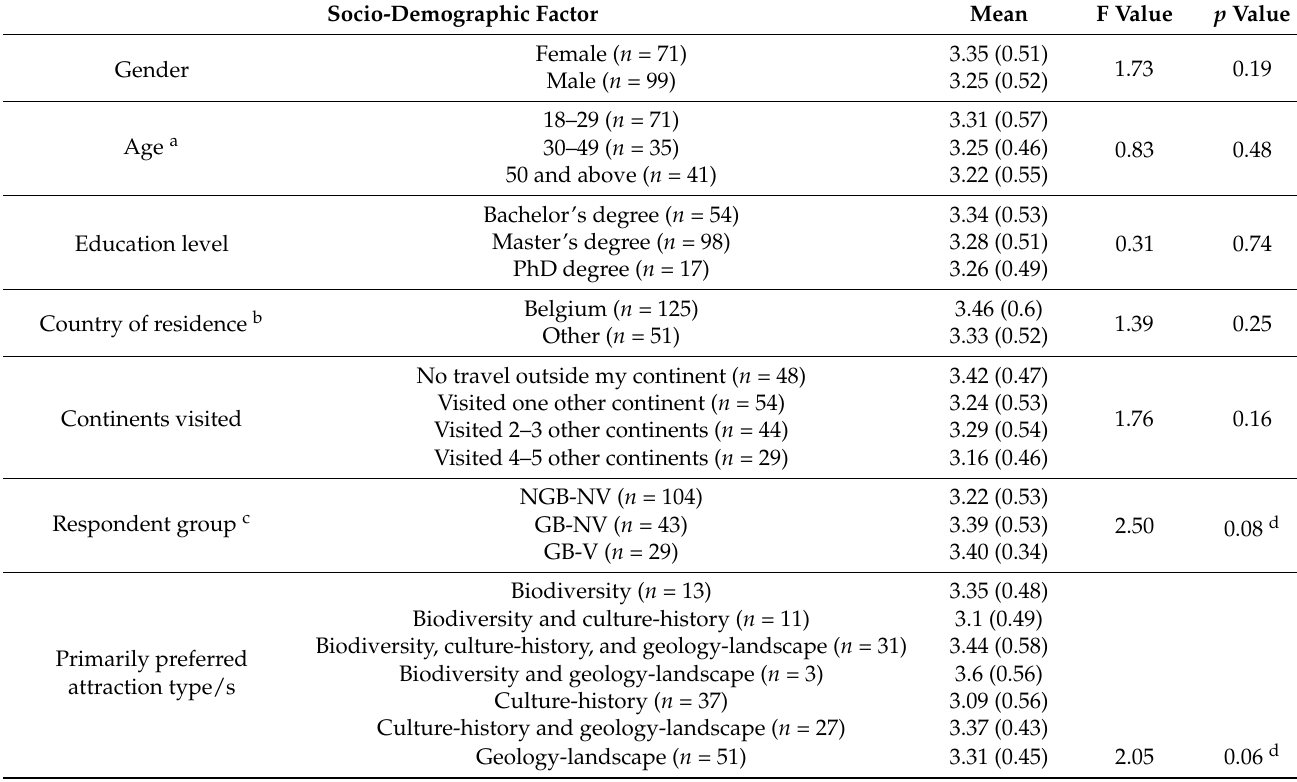
Table 1. Mean scenic beauty ratings (scale range 1–5; standard deviations in parentheses) of the 34 geosites as a function of socio-demographic factors of the respondents ( n is the number of persons). For information on the socio-demographic background of the respondents, see Table A3 in Appendix